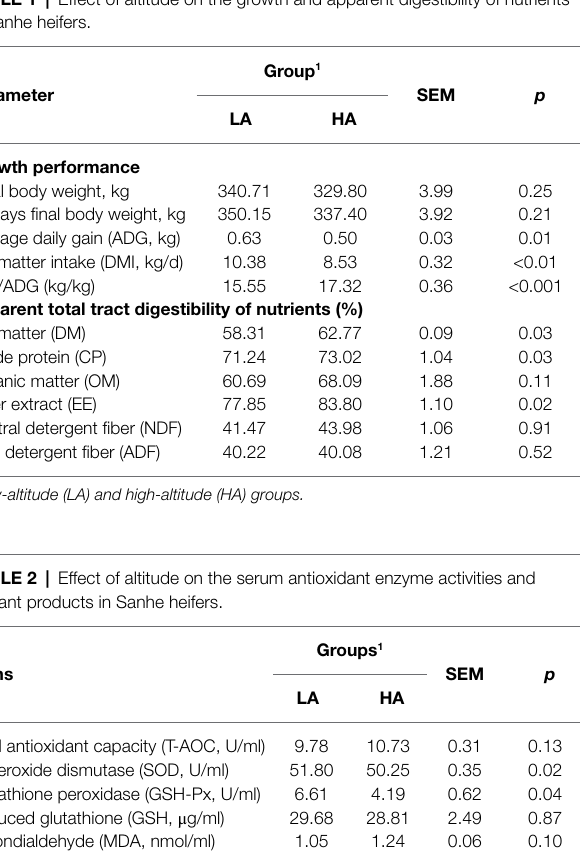
TABLE 1 | Effect of altitude on the growth and apparent digestibility of nutrients in Sanhe